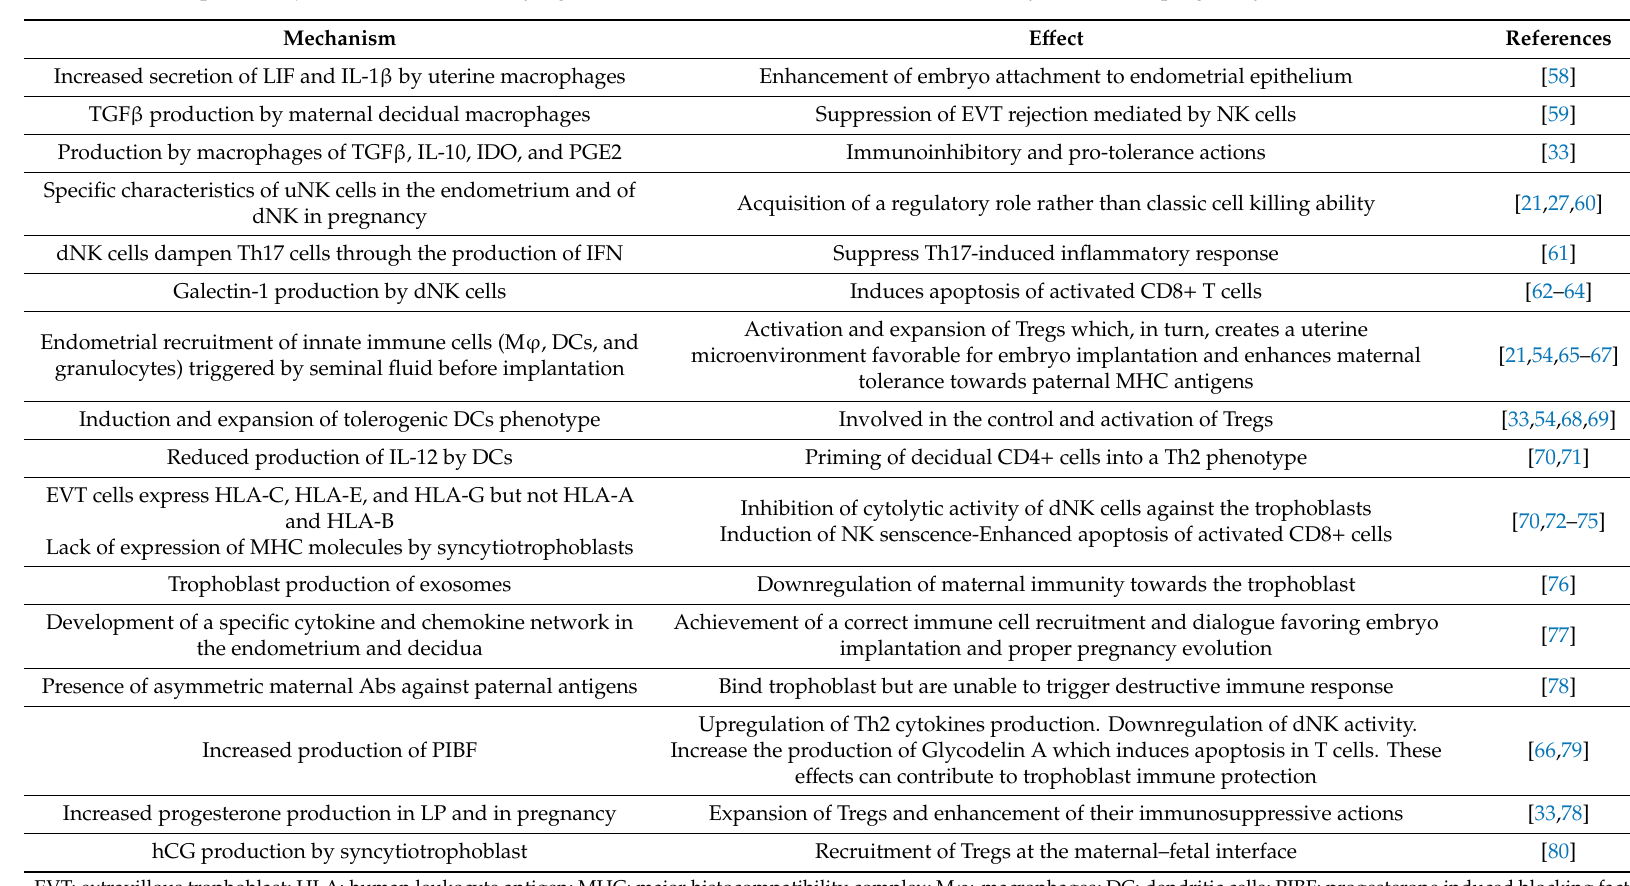
Table 4. Proposed major mechanisms underlying maternal immune tolerance towards the embryo in normal pregnancy in the endometrium and decidua.